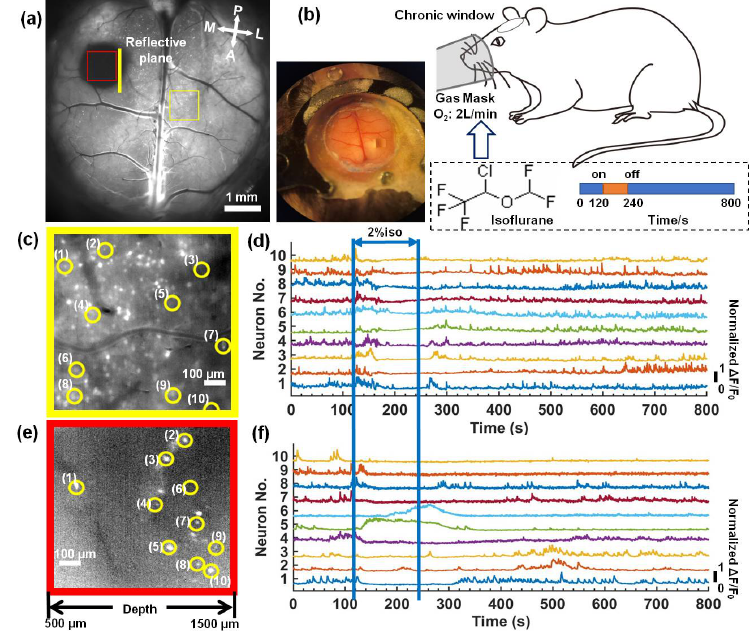
Figure 5. Deep in vivo functional imaging of mouse brains anesthetized by isoflurane. ( a ) The standard deviation projection of 600 time-lapse images of the mouse brains. Scale bar: 1mm. ( b ) A schematic diagram of the experiment. ( c , e ) Magnified views of the subregions marked in ( a ). Scale bar: 100µm. ( d , f ) Fluorescence signal fluctuation ( ∆ F/F 0 ) for neurons in yellow circles in ( c , e